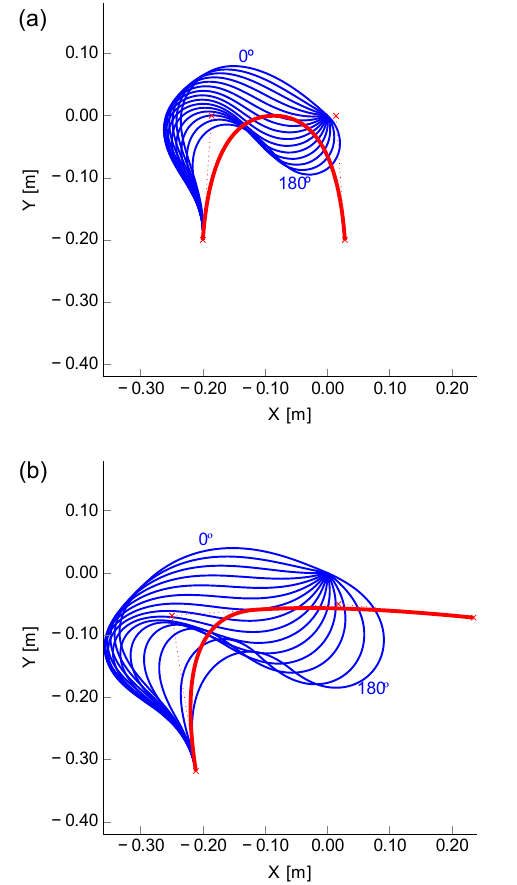
Figure 6. Example 1: shape in neutral position (red) and at the 15 increments of applied rotation of the endpoint about the origin (blue). (a) Initial shape and (b) optimum shape.